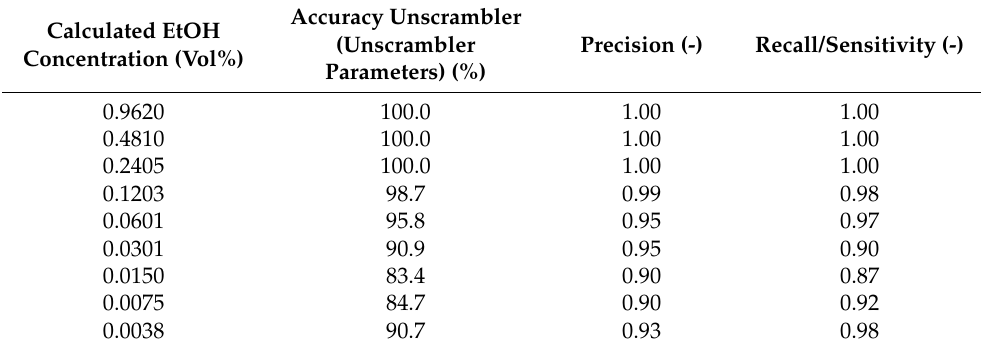
Table 2. Calculated mean value for accuracy, precision, recall/sensitivity, and computation time for each concentration with the c-value and gamma obtained from the algorithm using Unscrambler X.